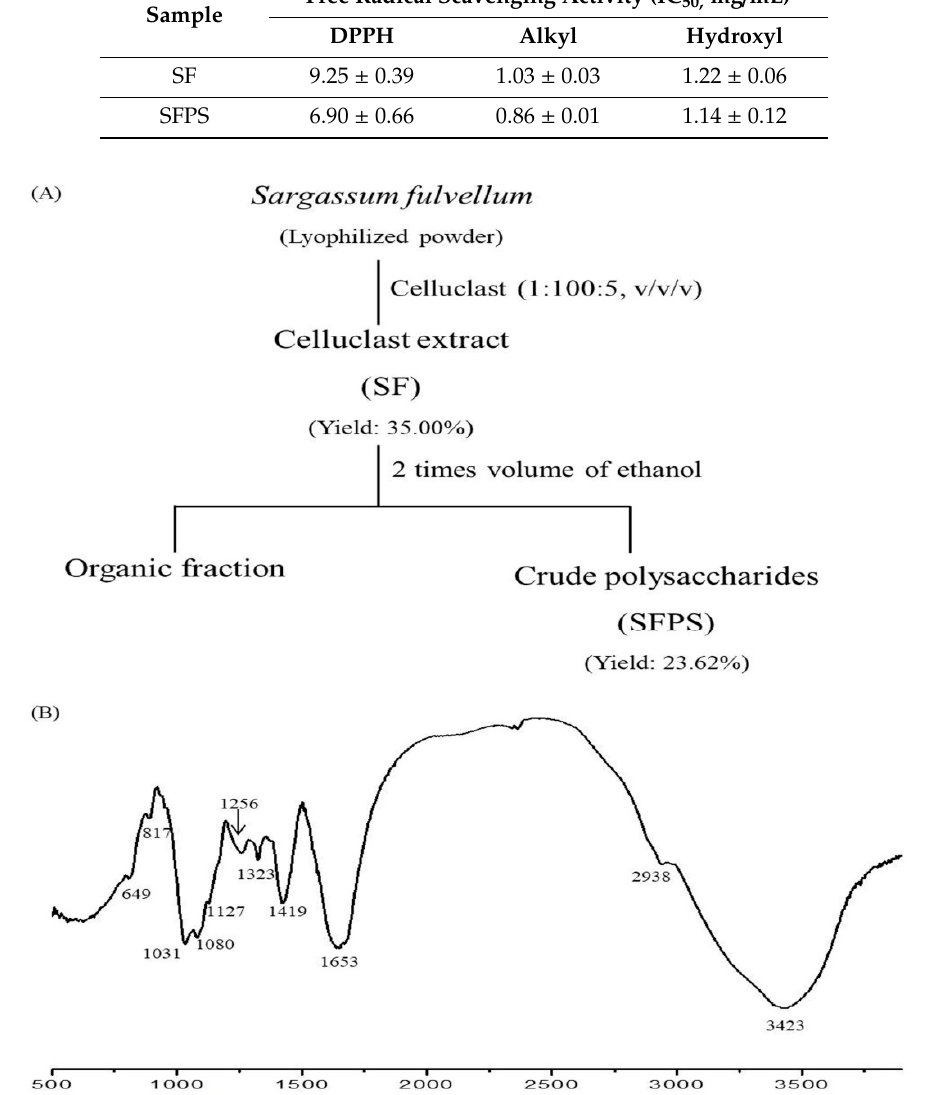
Figure 1. Preparation and characterization of SFPS. ( A ) Extraction protocols; ( B ) FTIR spectrum of